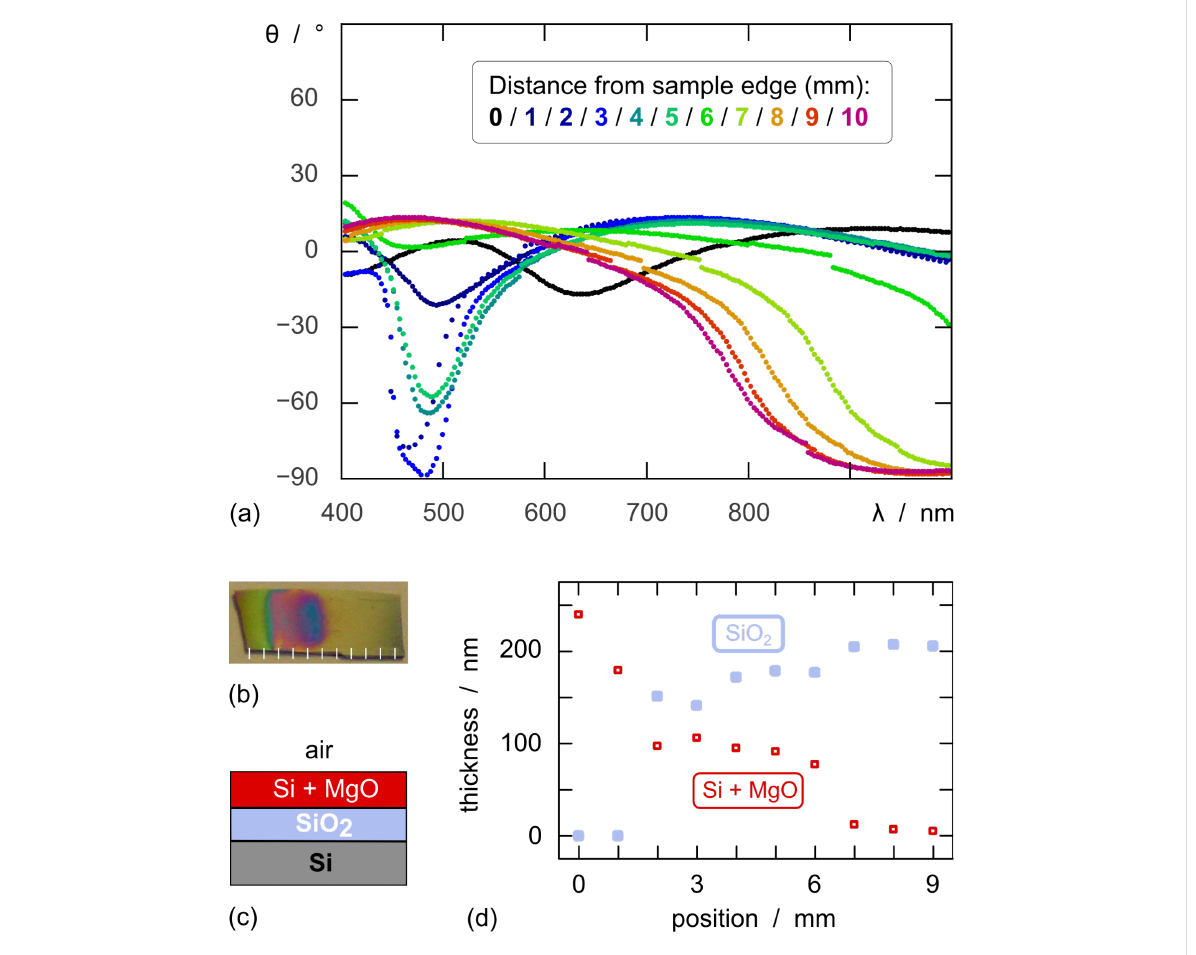
Figure 3: Reaction of a 200-nm thick SiO 2 layer on a silicon wafer with Mg element at 700 °C: (a) spectroscopic ellipsometry orientation data recorded at various positions of the sample; (b) photograph showing the inhomogeneous reaction extent and the position of the ellipsometric measurements; (c) layer stack used to model the ellipsometry data: the mixed layer is treated as a 1:1 mixture with the Lorentz–Lorentz model; (d) results of the fit: thicknesses of the unreacted SiO 2 and converted Si + MgO depending on the distance from the sample edge. The experimental data are presented together with the fit curve at each position of the sample in the Supporting Information File 1 (Figure S1).